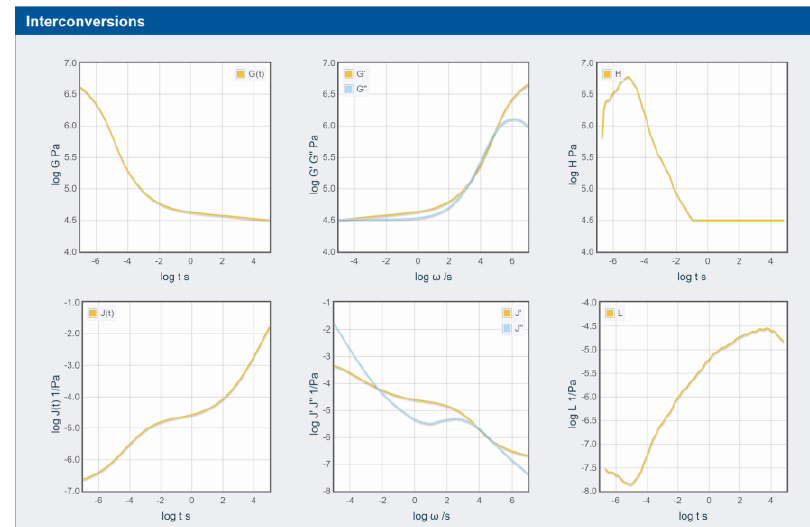
Figure 9. Relaxation modulus, G’ & G’’, relaxation spectrum, creep compliance, J’ & J’’, and the retardation spectrum are all fundamentally interconvertible. The app is at www.stevenabbott.co.uk/practical-rheology/Interconversions.php.